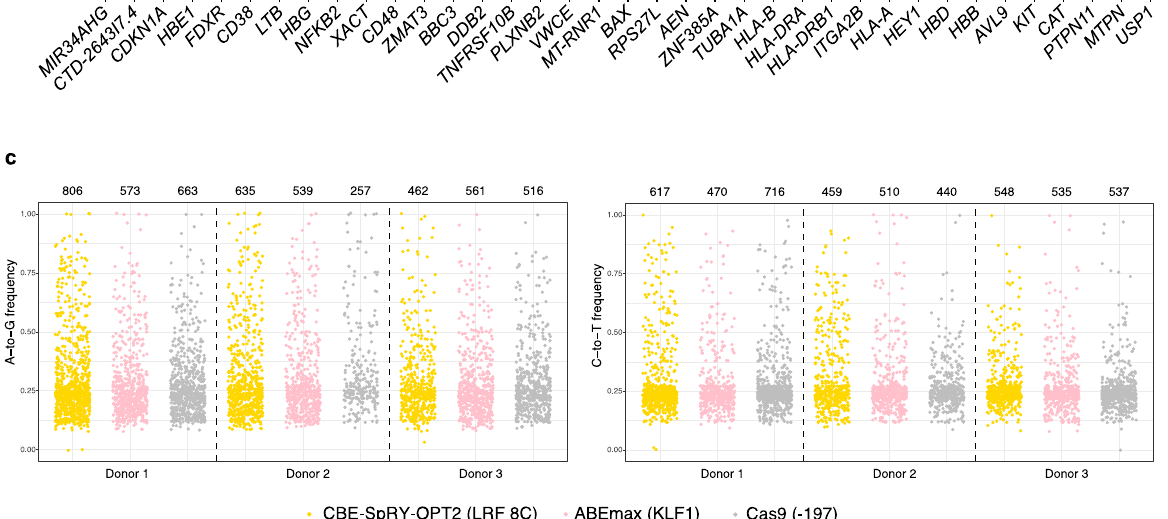
generated are indicated on top of each plot. b Expression of statistically signi fi cant (FDR<0.05) upregulated or downregulated genes, as measured by the log2-fold change of FPKM of edited samples over control samples. Data are expressed as mean±SEM ( n =3 biologically independent experiments, 3 donors). c Strip plots showing the variant allele frequency of A>G mutations or C>T mutations in RNA observedinHSPCsobtainedfromthreedifferentHD.Thetotalnumberofmutations are indicated above each sample. Source data are provided as a Source Data fi le.